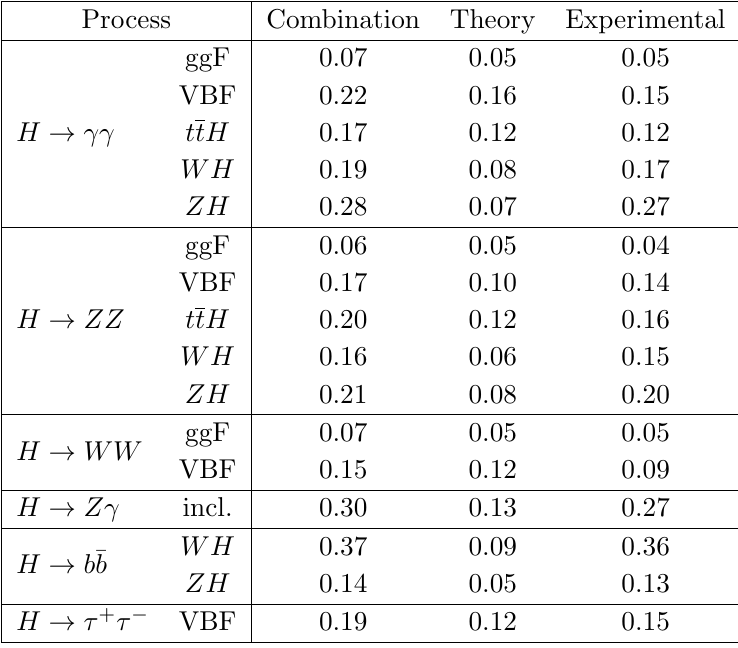
Table 1 . Estimated relative uncertainties on the determination of single-Higgs production channels at the high-luminosity LHC (14 TeV center of mass energy, 3 = ab integrated luminosity and pile- up 140 events/bunch-crossing). The theory, experimental (systematic plus statistic) and combined uncertainties are listed in the ‘Theory’, ‘Experimental’ and ‘Combination’ columns respectively. All the estimates are derived from refs. [10, 11] and [3, 31].